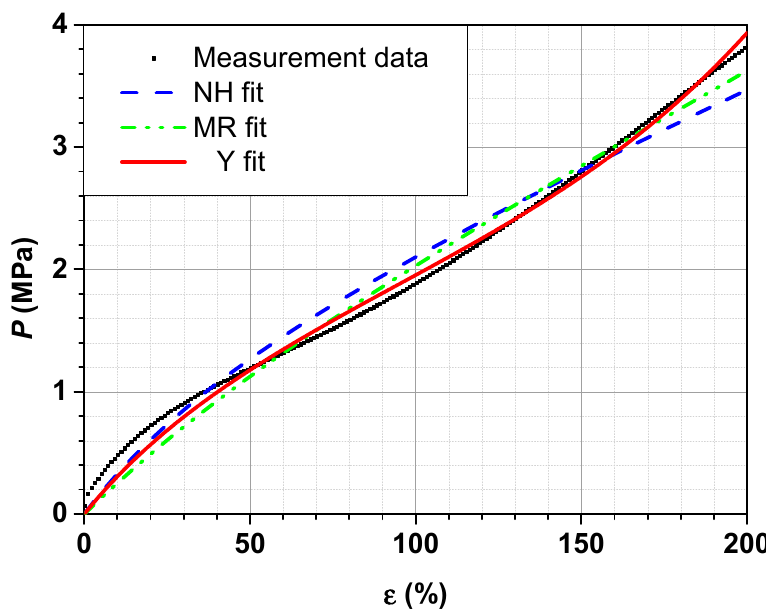
ε (%) Figure 4. Fit of a representative stress–strain curve of the SBR filled with 70 phr N234 with Abaqus using neo-Hooke (NH), Mooney–Rivlin (MR) and Yeoh (Y) models. Table 2. Mean squared error of the measurement curve in tensile and the fit curves using neo-Hooke, Mooney–Rivlin and Yeoh models. Neo-Hooke Table 3. Fit parameters of a stress–strain curve of the SBR filled with 70 phr N234 using neo-Hookean, Mooney–Rivlin and Yeoh models. 𝑪 𝑪 𝟏 𝟐 [MPa]